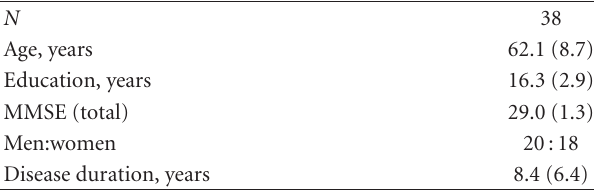
Table 1: PD participant characteristics; means